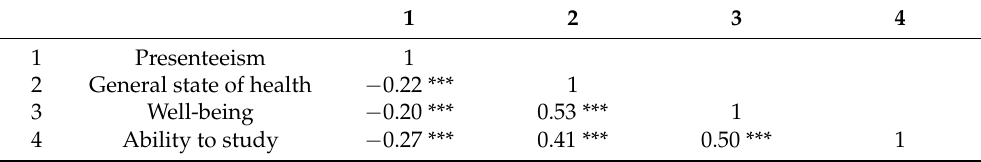
Table 4. Intercorrelations of the variables (health status, well-being, and ability to